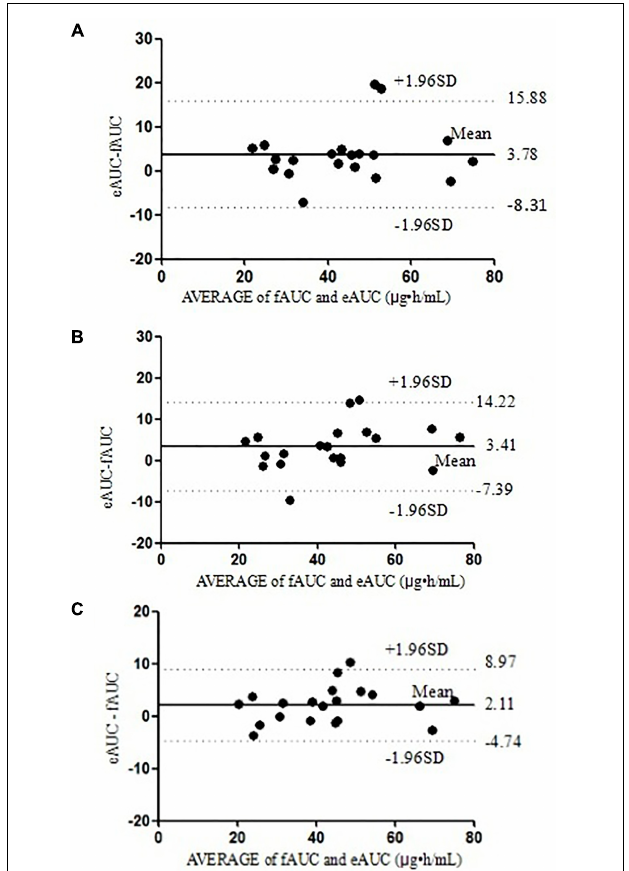
FIGURE 3 | The Bland–Altman analysis agreement between the fAUC and eAUC using model 2 (A) , model 3 (B) , and model 4 (C) .